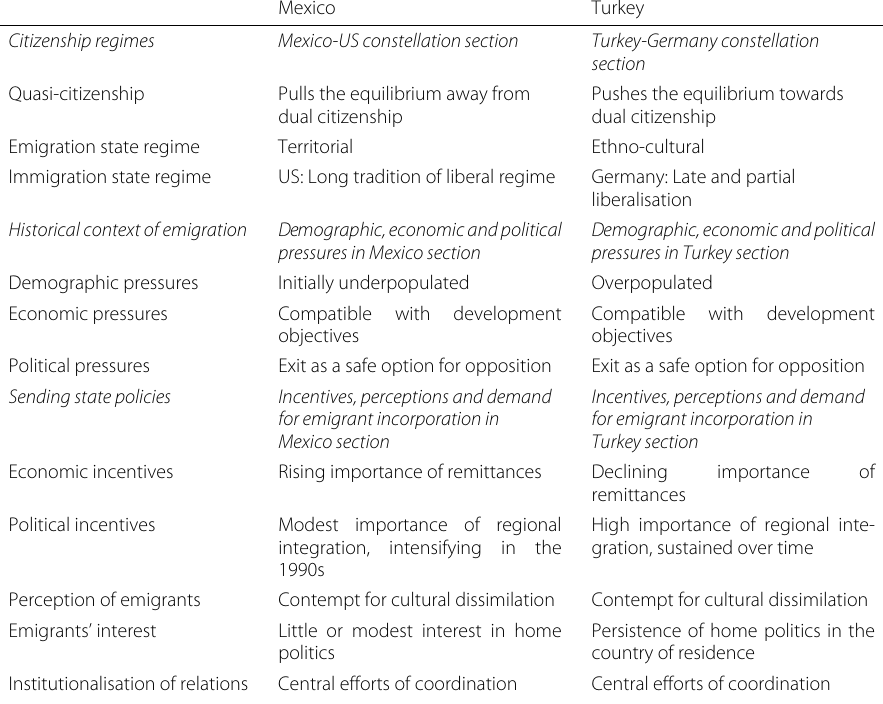
Table 3 Summary of